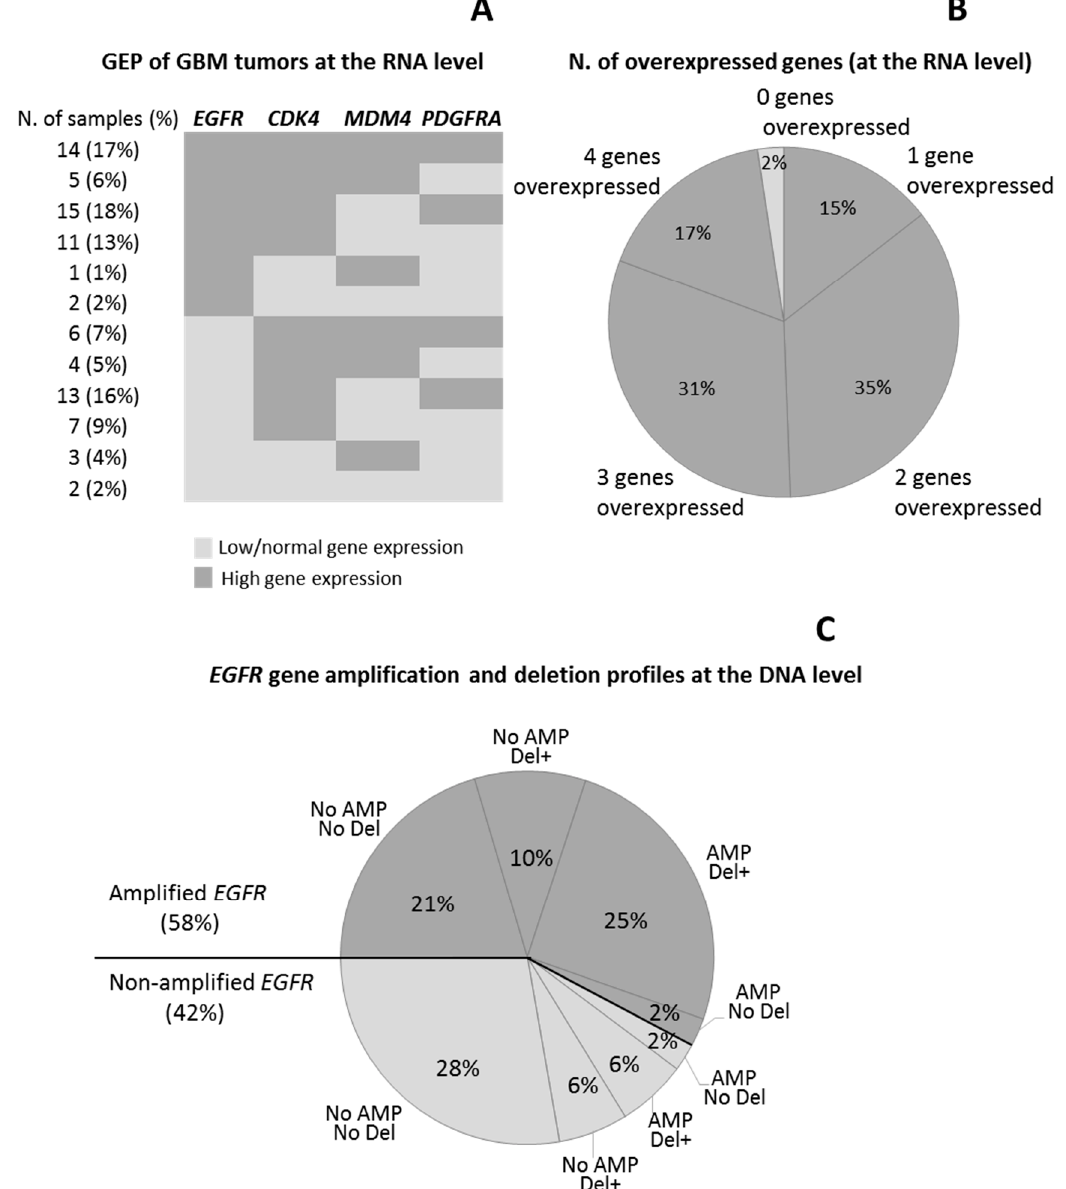
Figure 2. Distribution of GBM cases according to the pattern ( A ) and number ( B ) of overexpressed ( EGFR , CDK4 , MDM4 , and PDGFRA ) genes, and the association between EGFR gene expression levels and the EGFR gene deletion/amplification profiles ( C ). Table 3. Association between the copy number (CN) status and gene expression profile of the EGFR , CDK4 , MDM4 , and PDGFRA genes in GBM.